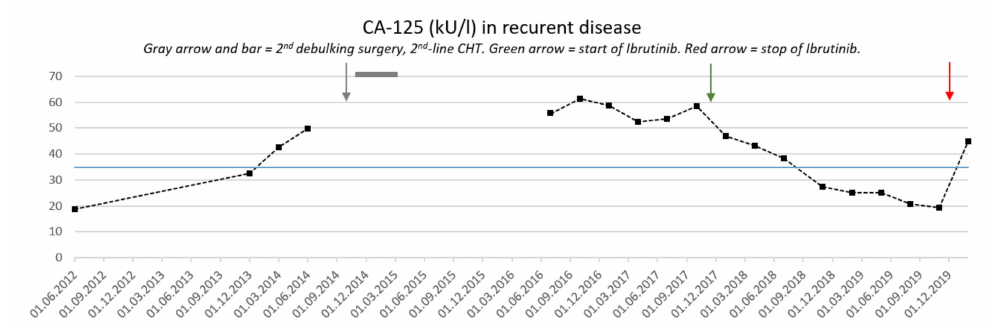
Figure 1. Development of CA-125 levels in recurrent disease. An increase was seen during the course of the disease, and debulking surgery with second-line chemotherapy was performed (grey arrow and grey bar). CA-125 monitoring was not continued postoperatively until July 2016, when elevated levels suggested recurrent (subclinical) disease. During expectant management, CA-125 dropped sharply after the initiation of ibrutinib therapy for a different indication (green arrow). After termination of ibrutinib intake (red arrow), a marked increase was